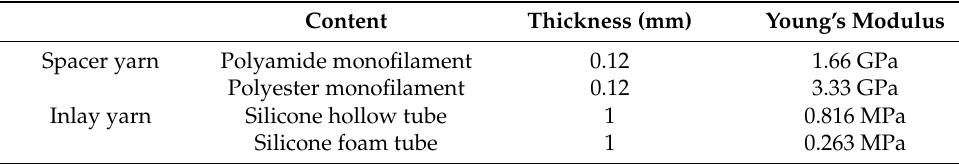
Table 1. Details of spacer yarn and inlay yarn used to construct fabric